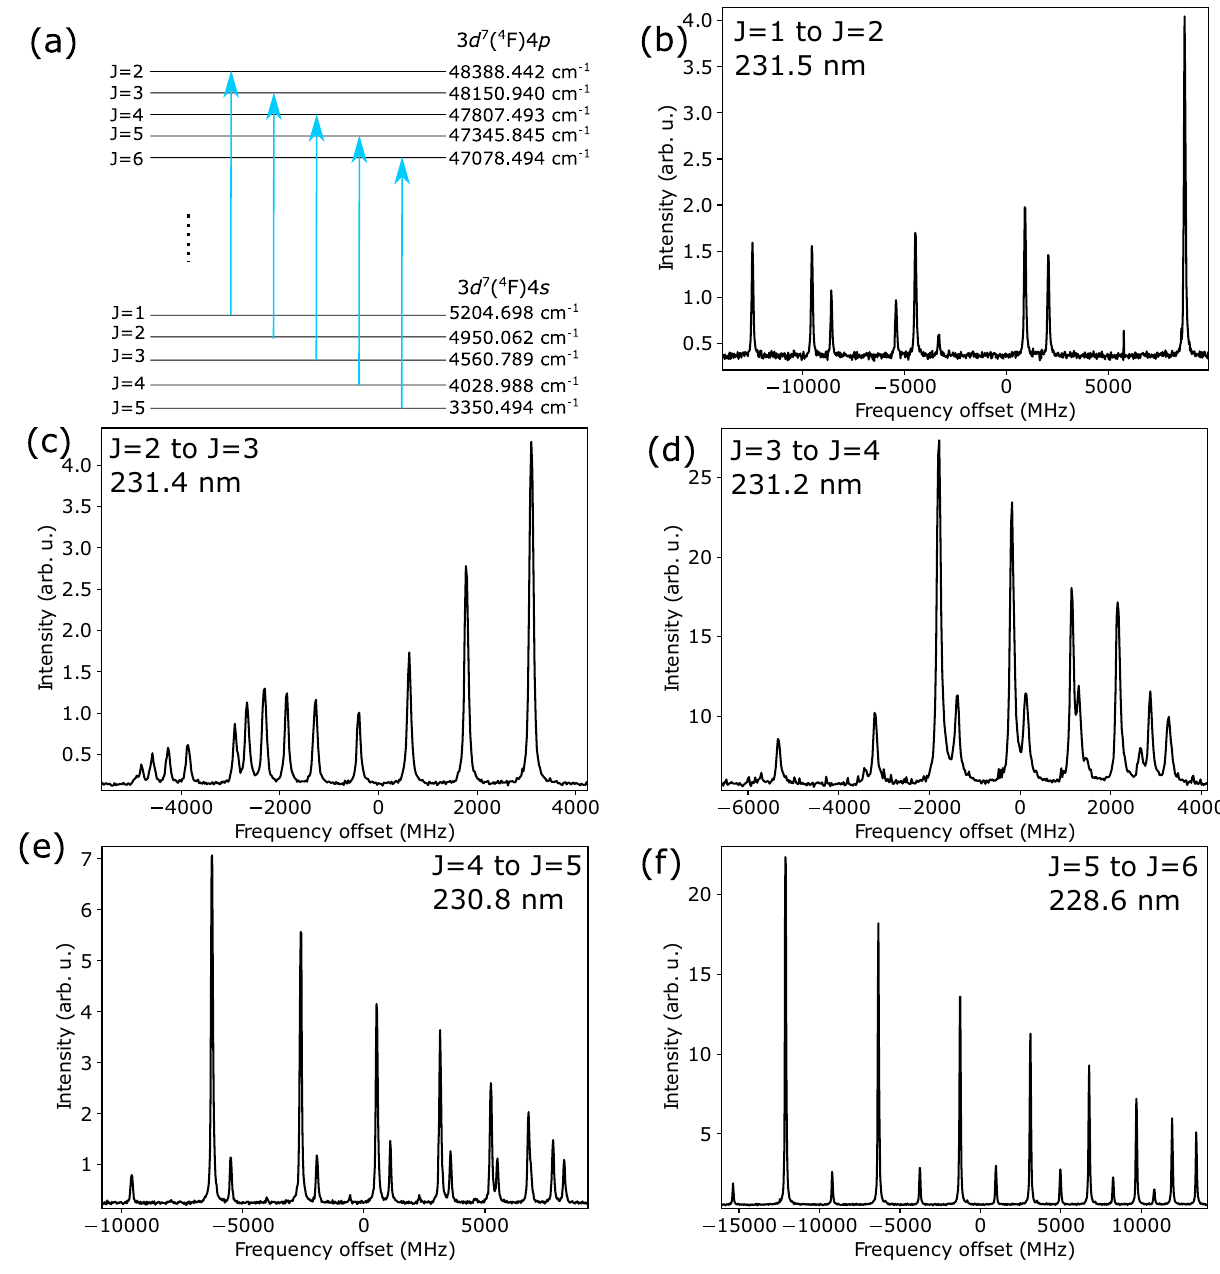
Figure 2. ( a ) Measured transitions in singly ionized Co. The extracted hyperfine parameters are presented in Table 1 separately for each level. ( b – f ) The measured hyperfine structure spectrum of transitions indicated in figure ( a ). The frequency axis is provided with an arbitrary offset. The intensity corresponds to 10 − 3 times the number of detected photons during the